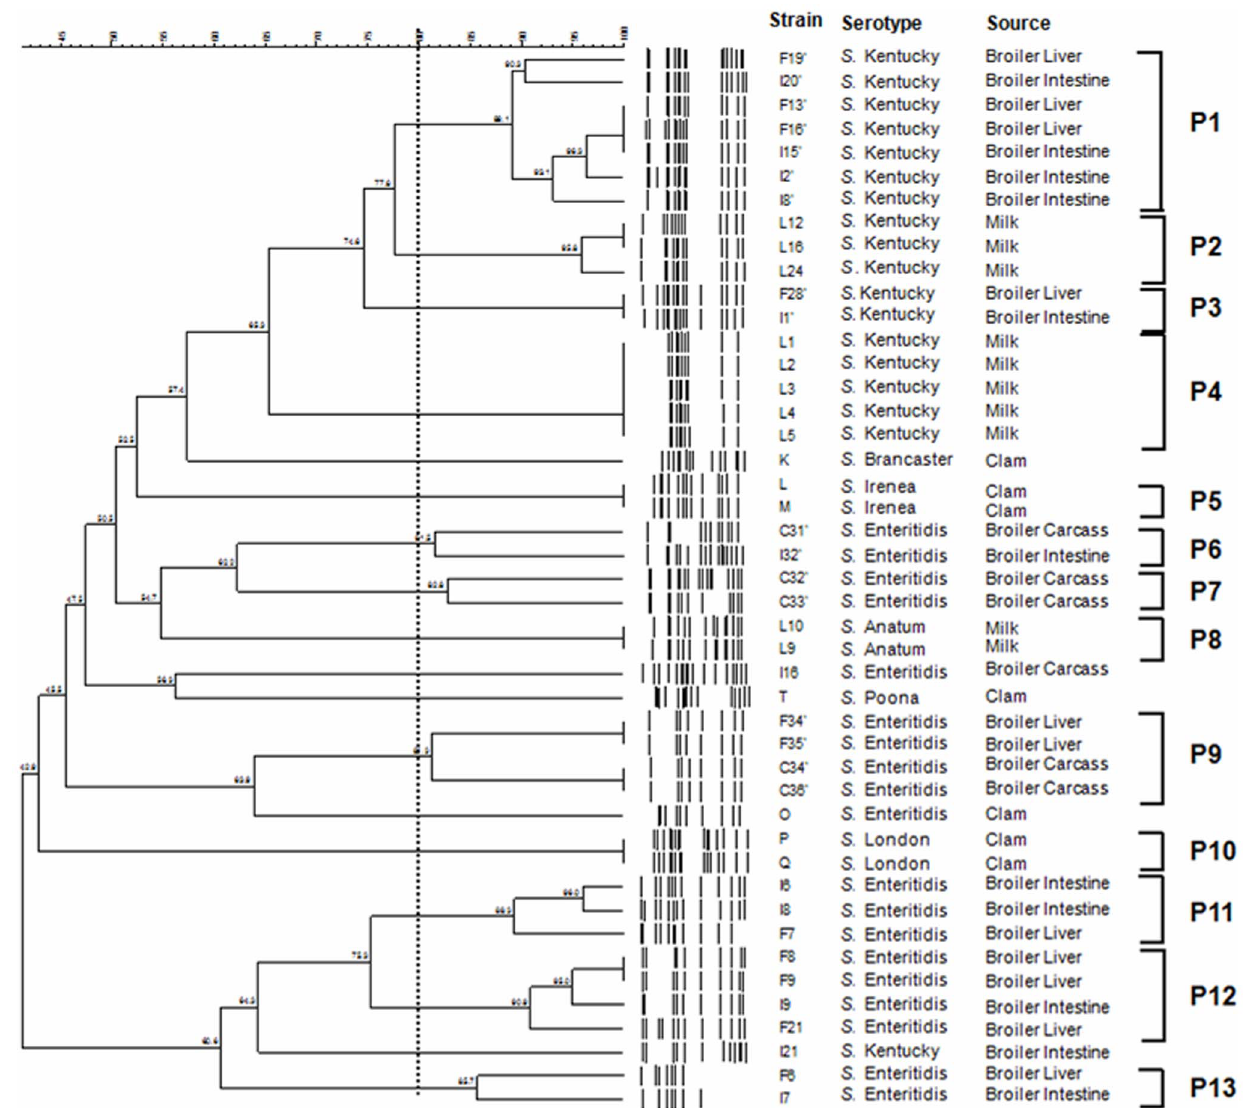
Figure 2. PFGE Dendrogram showing the relationship between Salmonella isolates. The similarities between strains were evaluated using the Dice coefficient and the UPGMA clustering method. Genetic similarity between samples in duplicate is 80%.